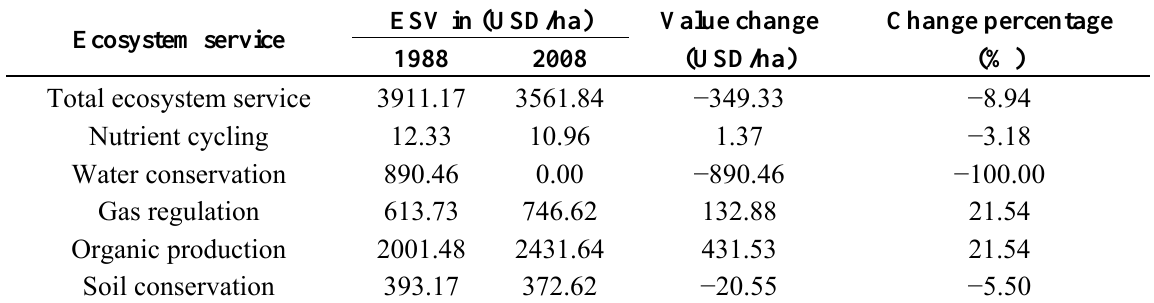
Table 2. Actual changes in ESV in the NCP during the period 1988–2008.